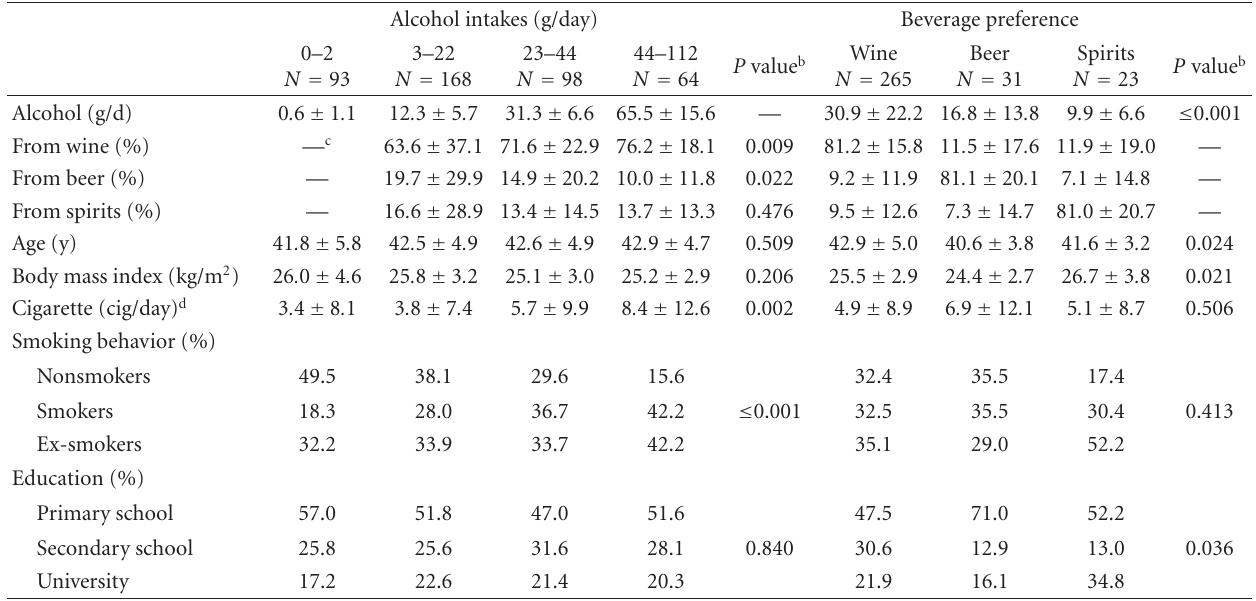
Table 1: Characteristics of the sample of 423 adult males according to alcohol consumption and beverage preference a .